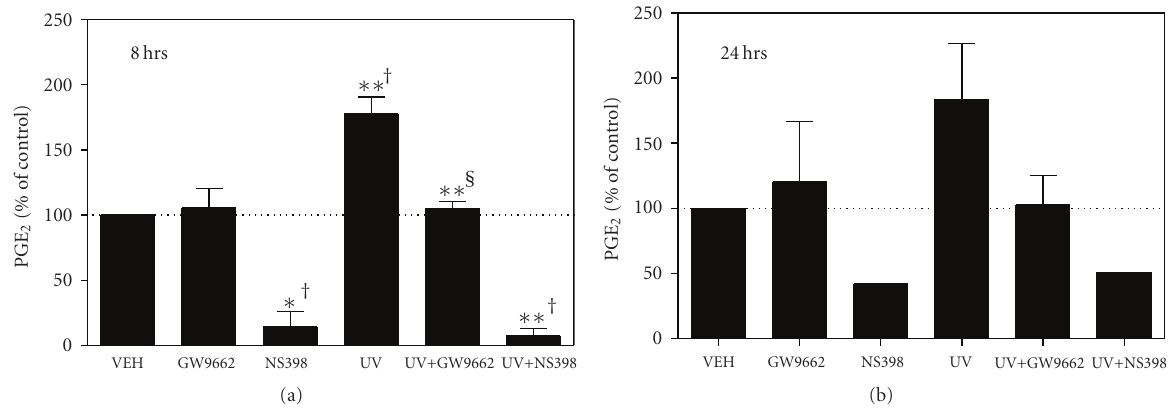
Figure 4: PPAR γ activation is a potent inducer of PGE 2 production in human epidermal explants. Human epidermal explants were prepared as described in the methods section and placed into K-SFM media (Invitrogen). Prior to UVB (UV) irradiation, the explants were pretreated with 1 μ M GW9662 for 1 hour or 10 μ M NS398 for 30 minutes. The explants were then washed once in PBS and irradiated with 1800 J/m 2 UVB. Media containing vehicle (CONT), 1 μ M GW9662, or 10 μ M NS398 were then added back and the explants were cultured for 8